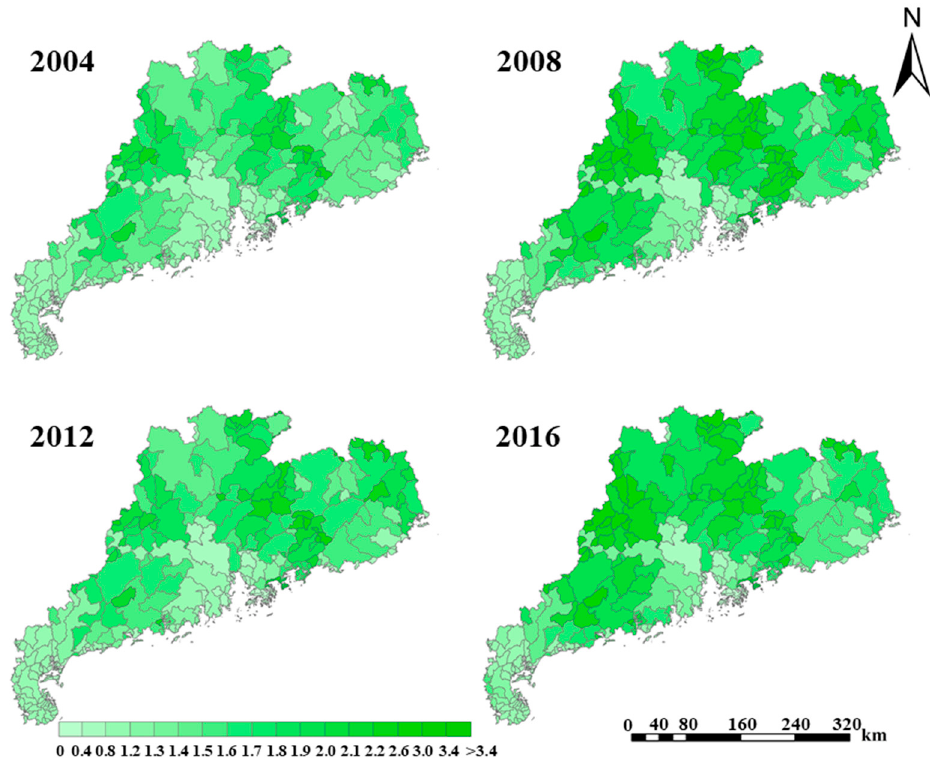
Figure 4. Spatial patterns of the annual mean leaf area index (LAI) in Guangdong.